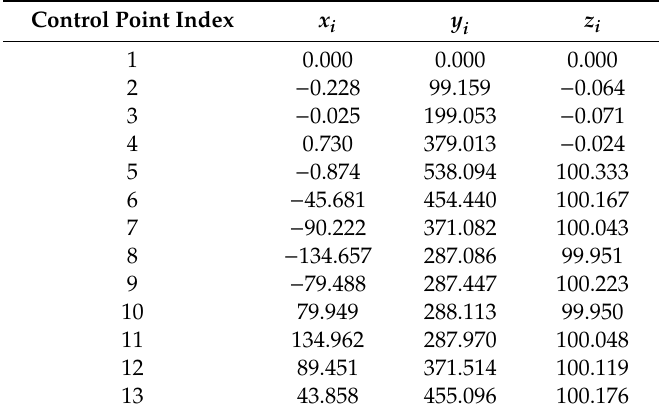
Table 3. Control point positions in the light pen coordinate system